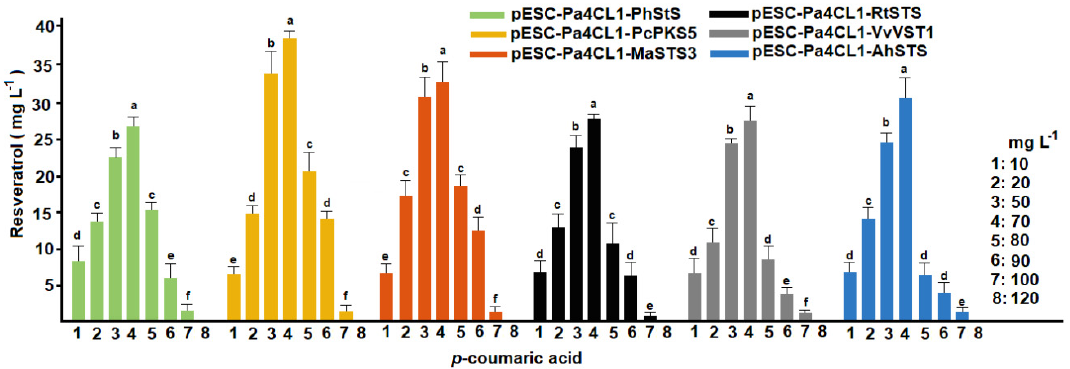
Figure 6. Conversion of p -coumaric acid into resveratrol by recombinant strains of S. cerevisiae containing six stilbene synthases growing at pH 6. Different letters indicate statistically significant differences ( p < 0.01). Error bars represent standard deviation of ten independent experiments (n = 10).